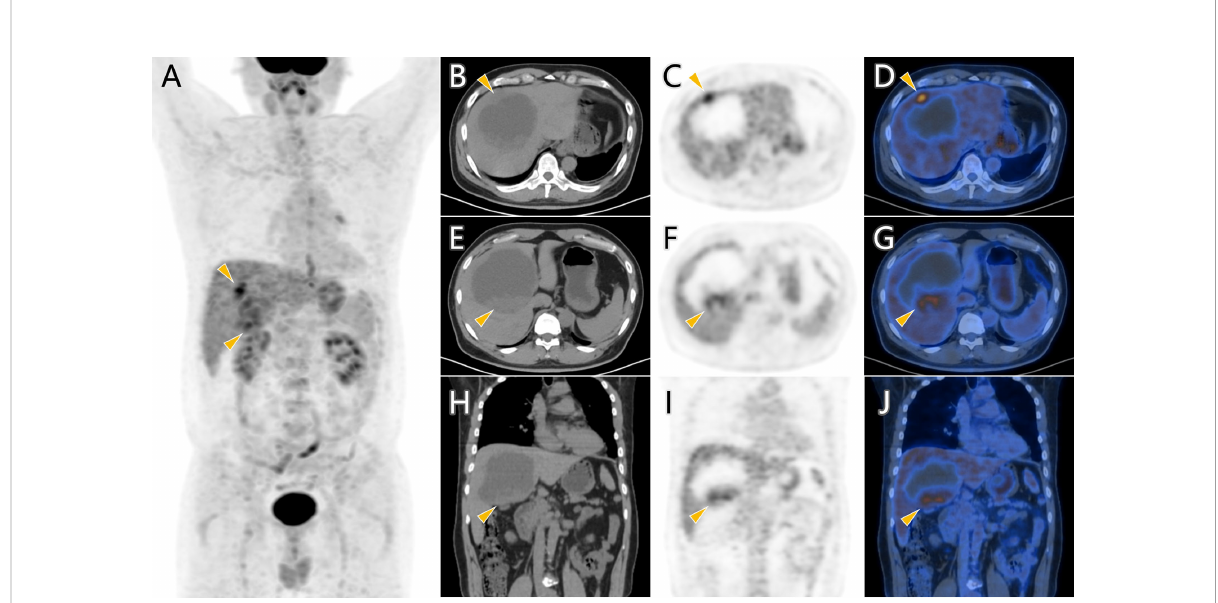
FIGURE 2 18 F-FDG PET/CT scan of the hepatic cystic mass. FDG-avid lesions (arrowhead) in MIP image (A) were demonstrated as moderate tracer uptakes in solid parts of the mass in axial images (B – G) and coronal images (H – J)